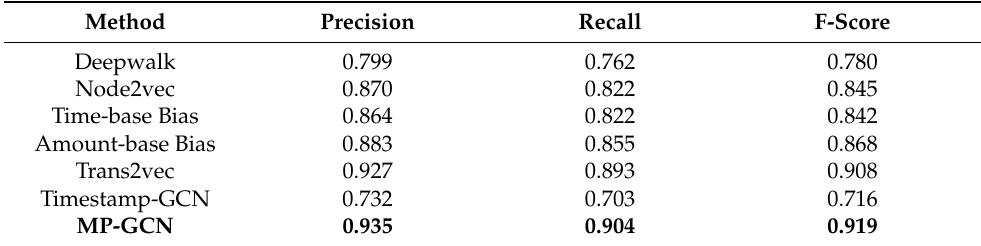
Table 1. Classification performance of different